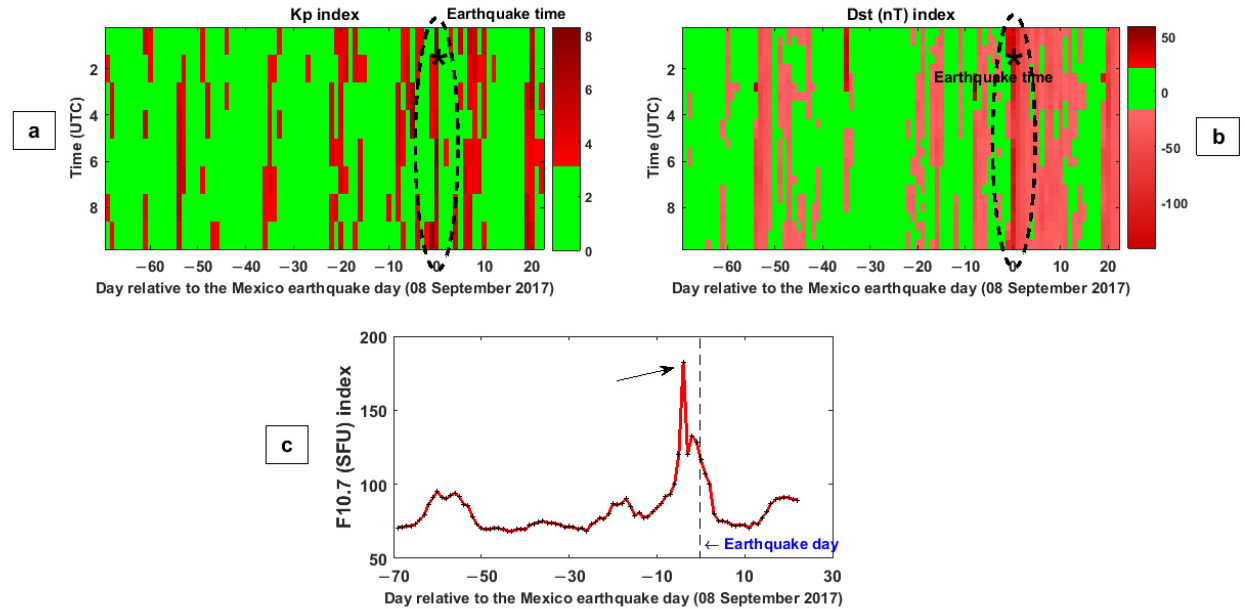
Figure 2. ( a – c ) shows, respectively, the variations of K p , D st , and the solar radio flux (F10.7) indices during the period of 1 April to 15 October 2017. An asterisk “*” indicates the earthquake time of Mexico (8 September 2017). The dotted ellipsoids represent the conditions around the earthquake time. The dotted line represents the earthquake day. The values of the geomagnetic indices are given as binary, i.e., red for disturbed magnetic times and green for quiet magnetic times.